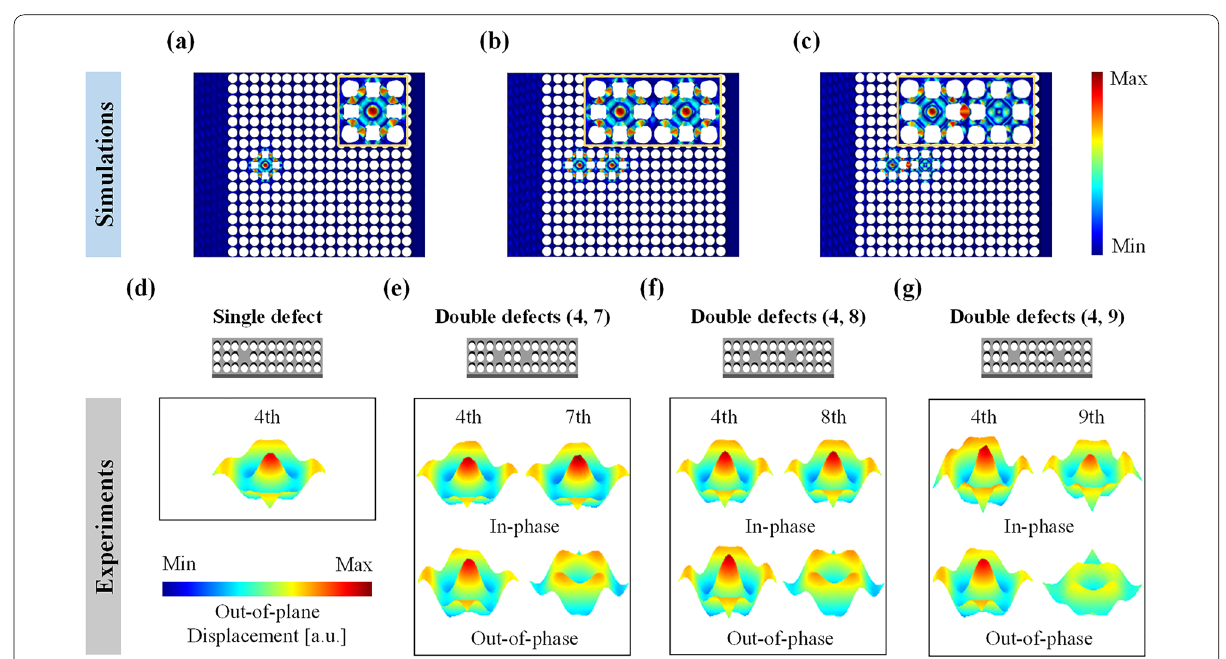
Fig. 3 Visualization results of the in‑phase and out‑of‑phase monopole‑like defect mode shapes inside the double defects of Phononic crystals: a – c time‑harmonic wave propagation behaviors in numerical simulations for the single defect case at 59.65 kHz and the double defect case at 59.51 and 59.85 kHz, respectively. d – g Experimentally scanned out‑of‑plane operating deflection shapes for the single defect case and the double defect case (4, 7), (4, 8), and (4, 9), respectively